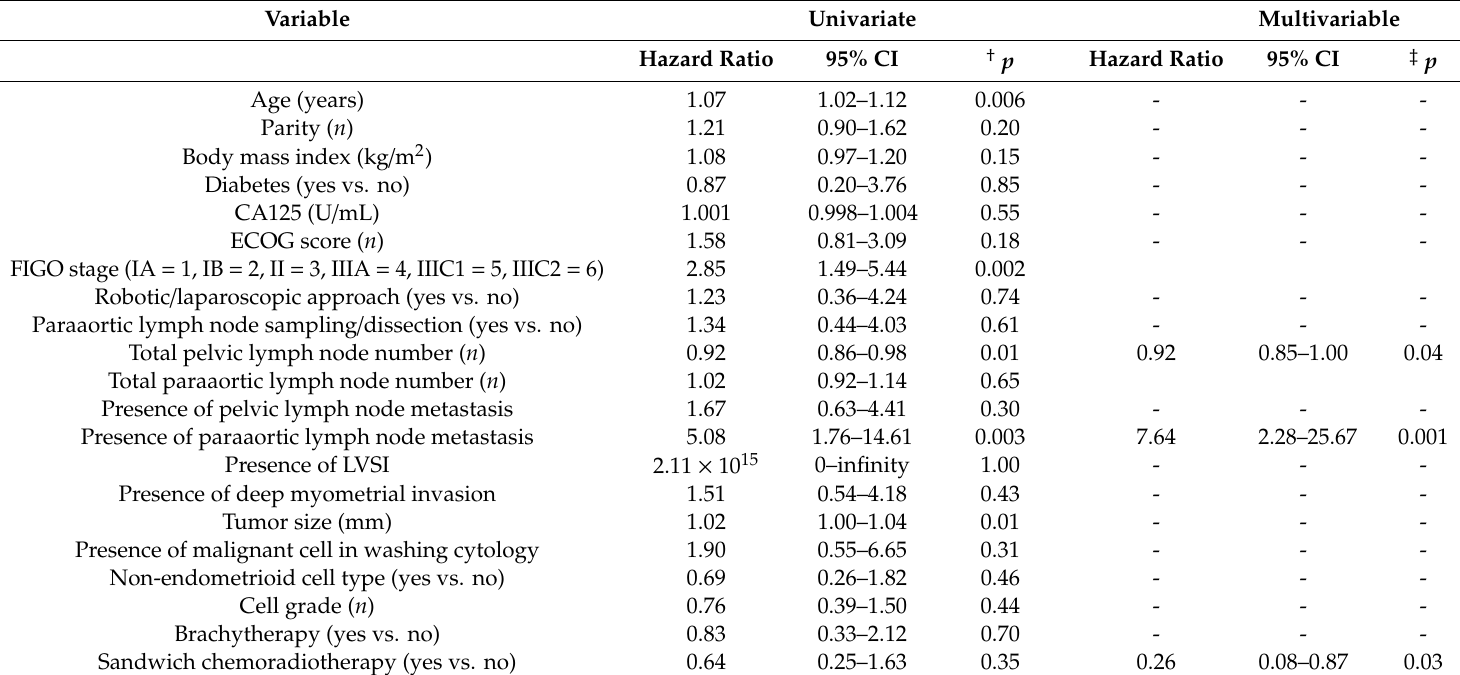
The abbreviations are the same as in Table 1. † Cox proportional-hazards model. ‡ Multivariable backward stepwise Cox proportional-hazards modeling was performed by using all variables in the univariate analysis until all remaining variable(s) with p <